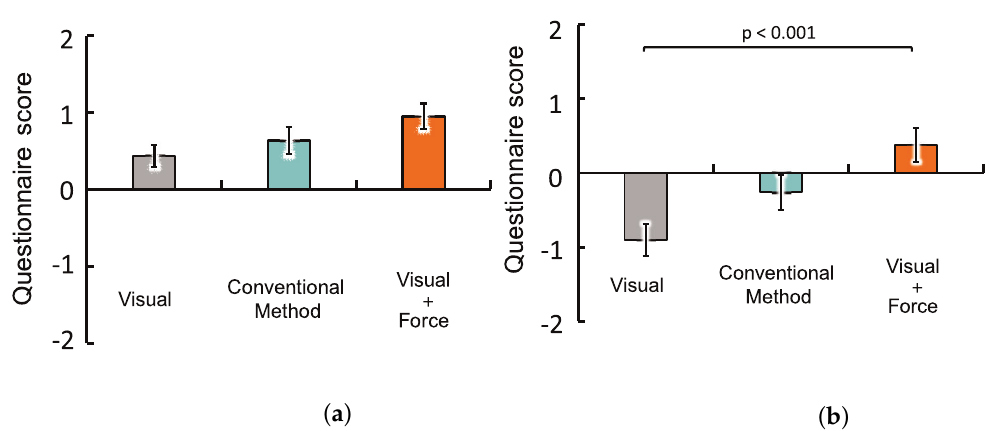
Figure 14. Statistical results of the subjective evaluation experiment: ( a ) immersive results; ( b ) illusion intensity results. Table 1. Results of a three-group test using one-way analysis of variance at the 0.05 significance